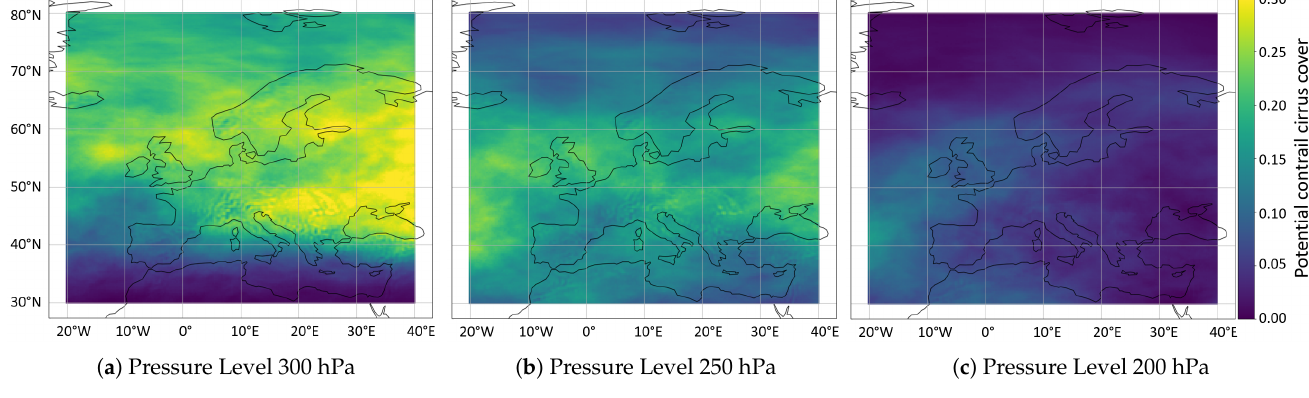
Figure 4. Influence of the flight altitude on the formation and persistence of contrails. The potential contrail cirrus cover over Europe is mapped for the first half of April with a fixed threshold of 95% for the relative humidity. ( a ) At FL300, a high-potential contrail cirrus cover is visible over the continent. ( b ) At FL340, the chances are highest in central Europe. ( c ) At FL390, only a small patch in the southwest with a potential contrail cirrus cover of 15–20% is